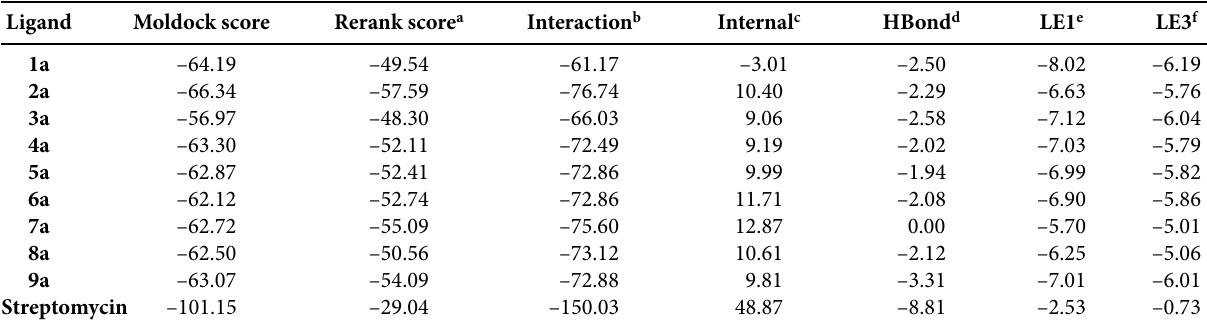
Table 4. Docking score of the compounds with 1KZN Ligand Moldock score Rerank score